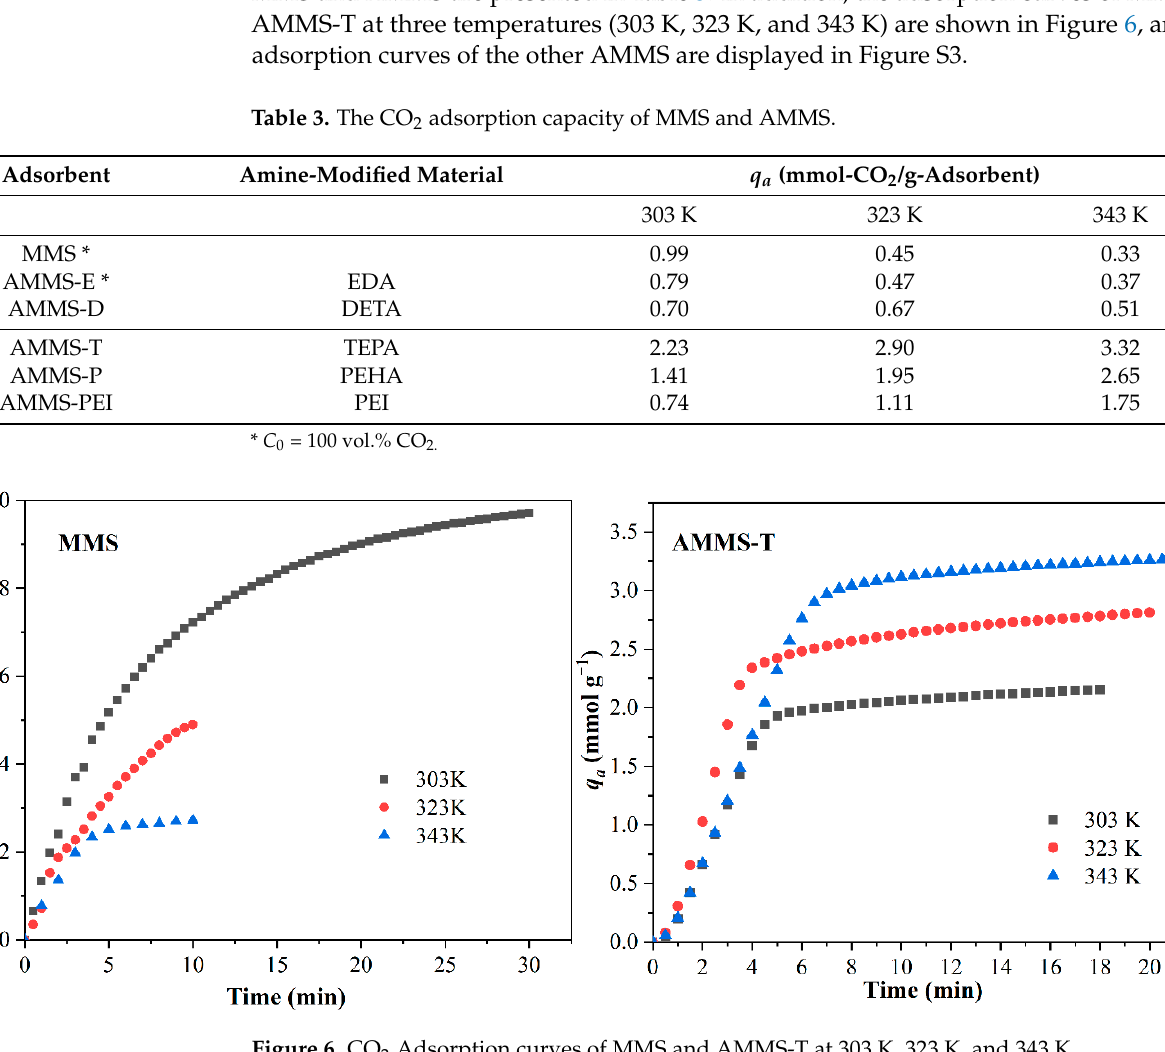
Table 4. Comparison of CO 2 adsorption capacity of AMMS-T (present study) with the literature. Support